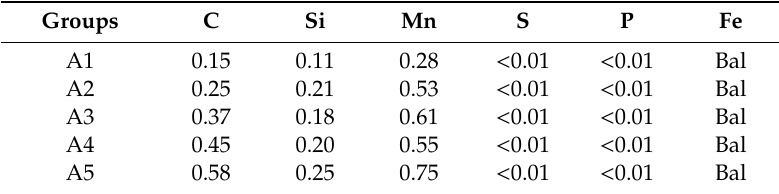
Table 1. The compositions of the samples